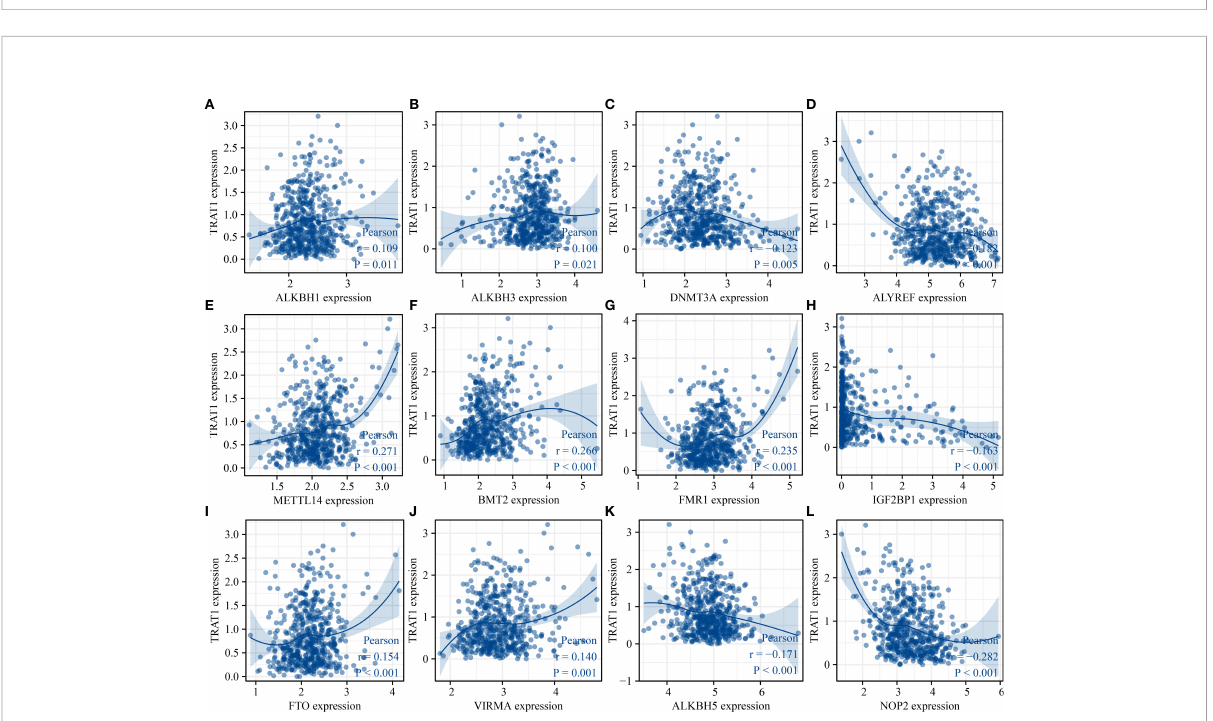
FIGURE 12 TRAT1 was associated with the RNA modi fi cation regulator genes. (A) ALKBH1; (B) ALKBH3; (C) DNMT3A; (D) ALYREF; (E) METTL14; (F) BMT2; (G) FMR1; (H) IGF2BP1; (I) FTO; (J) VIRMA; (K) ALKBH5; (L) NOP2.